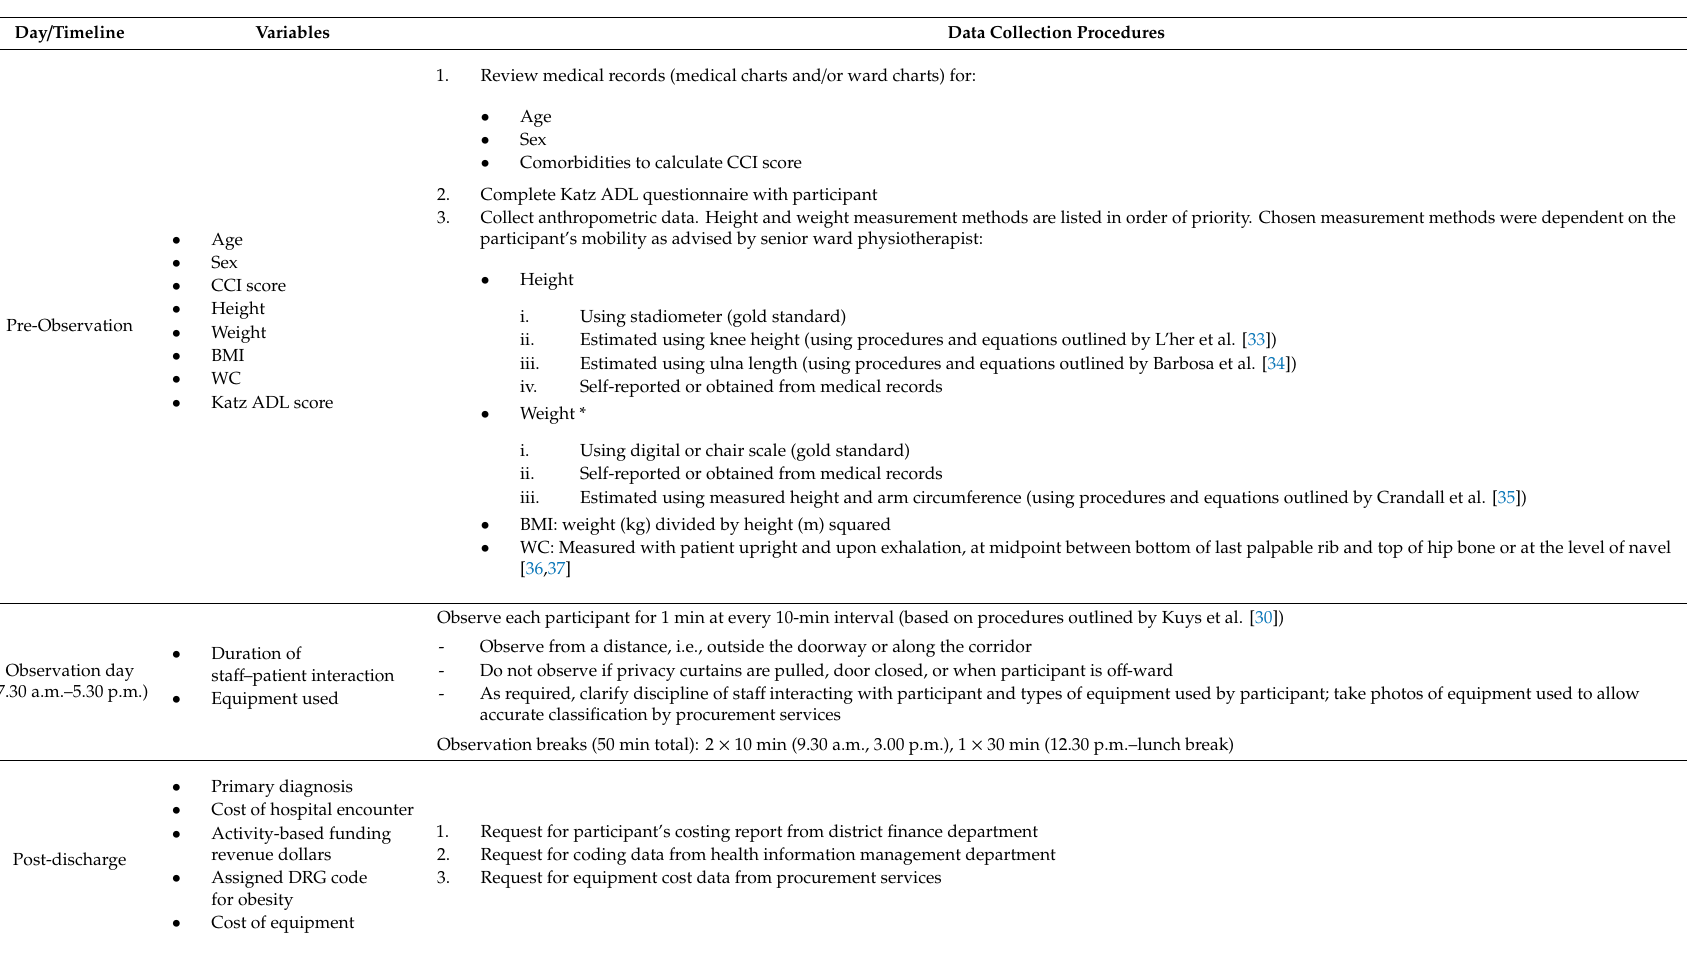
Table 1. Summary of data collection procedures for each consented